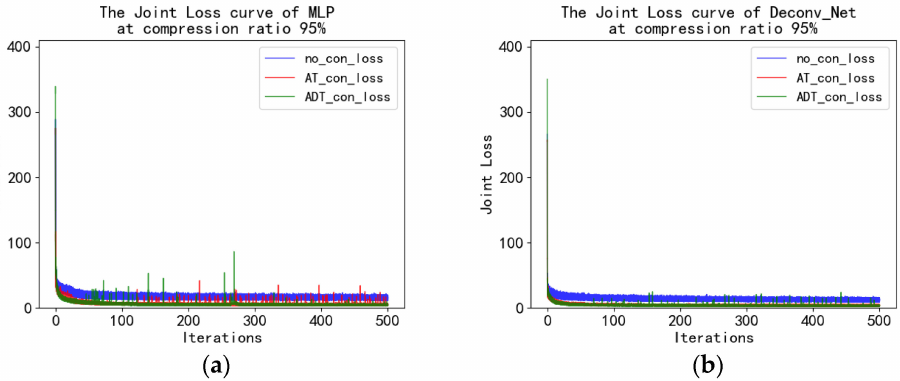
Figure 12. Comparison of ( a ) reconstruction accuracy and SSIM ( b ) between MLP and Deconv at a compression ratio of 95%.